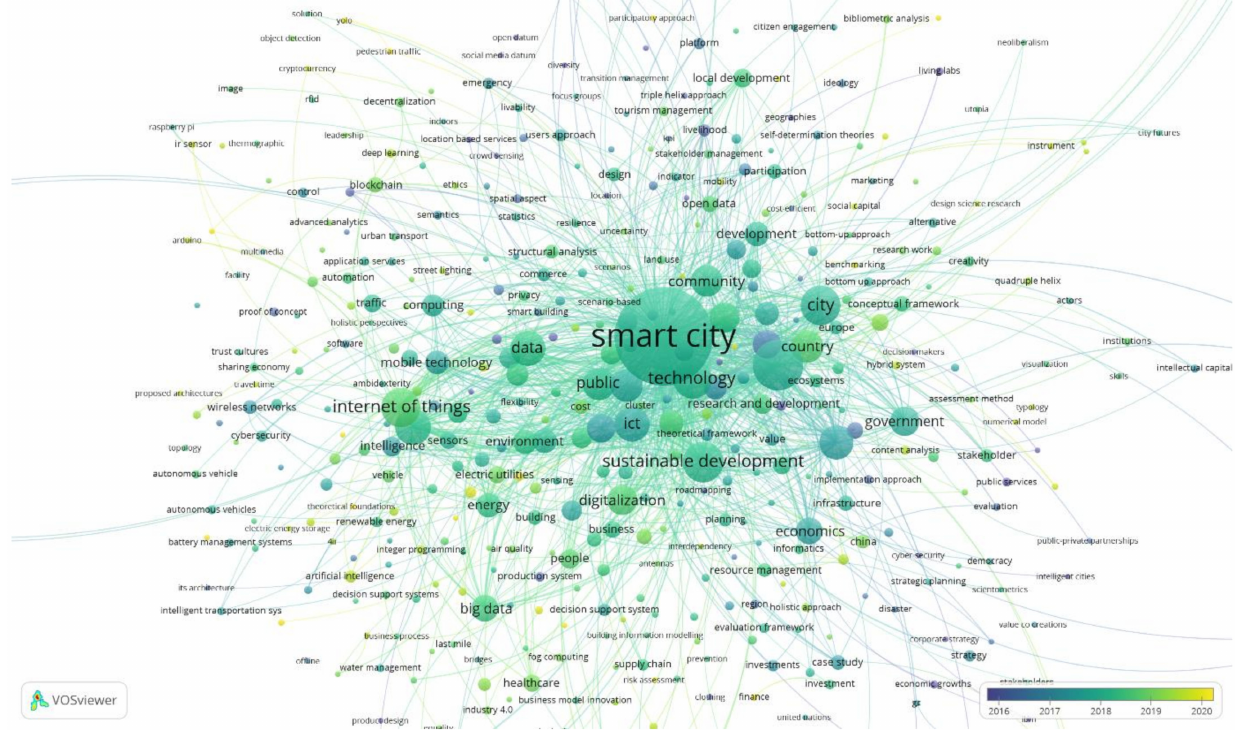
Figure 12. Density